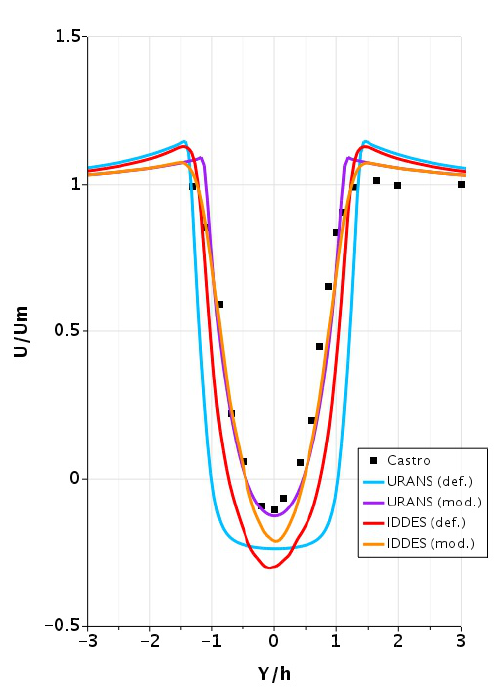
Figure 6. Comparison of Spanwise Mean Velocity of along the Symmetry Plane at x / h = 2.0 and z / h = 0.5.